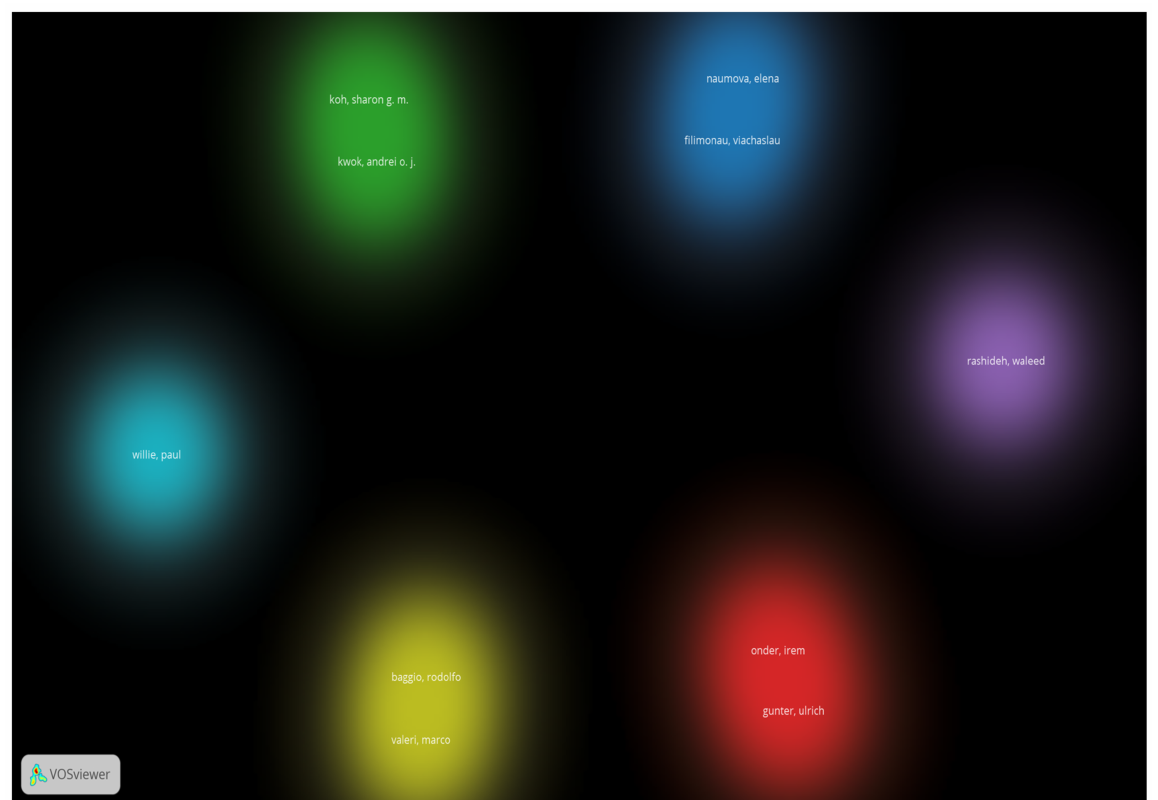
Figure 11. Coauthorship with author networks. Source: Analysis by Authors through